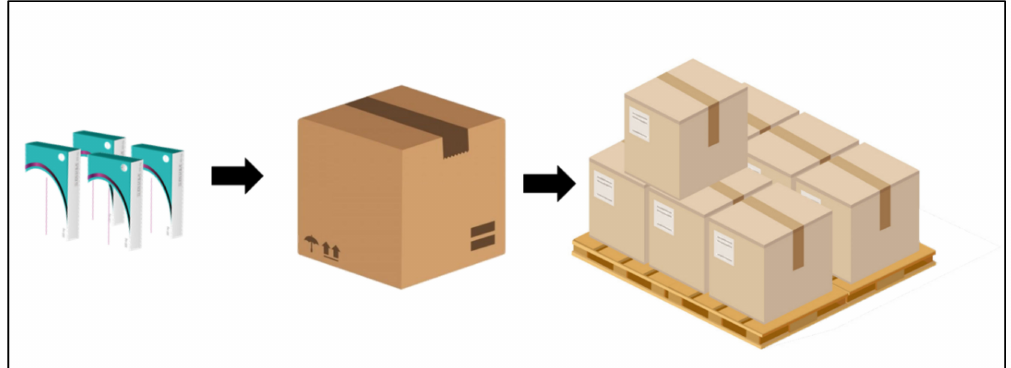
Figure 2. Serialization and packaging hierarchy (unit box, case box, and